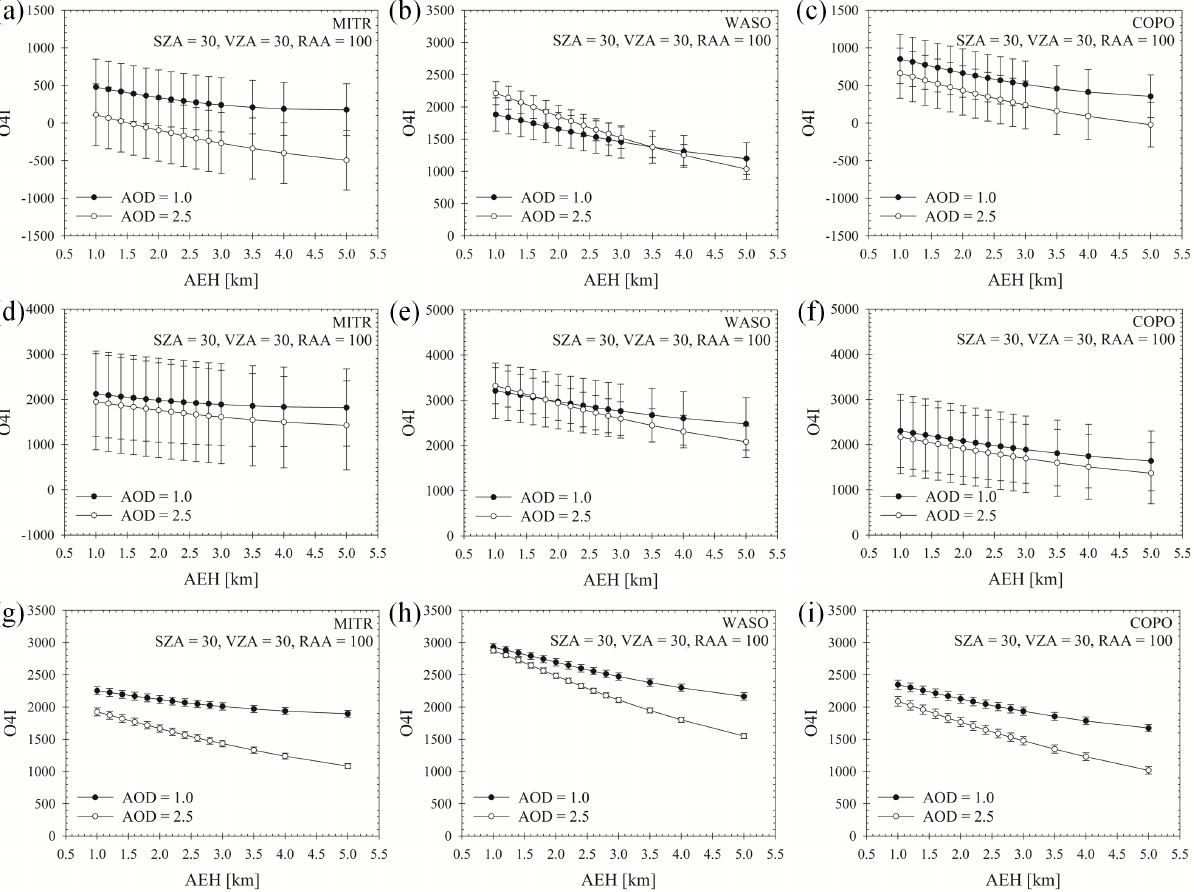
Figure 4. The O4I at 360nm band for (a) MITR, (b) WASO, and (c) COPO; (d) at 380nm band for MITR, (e) WASO, and (f) COPO; and (g) at 477nm band for MITR, (h) WASO, and (i) COPO as a function of AEH.